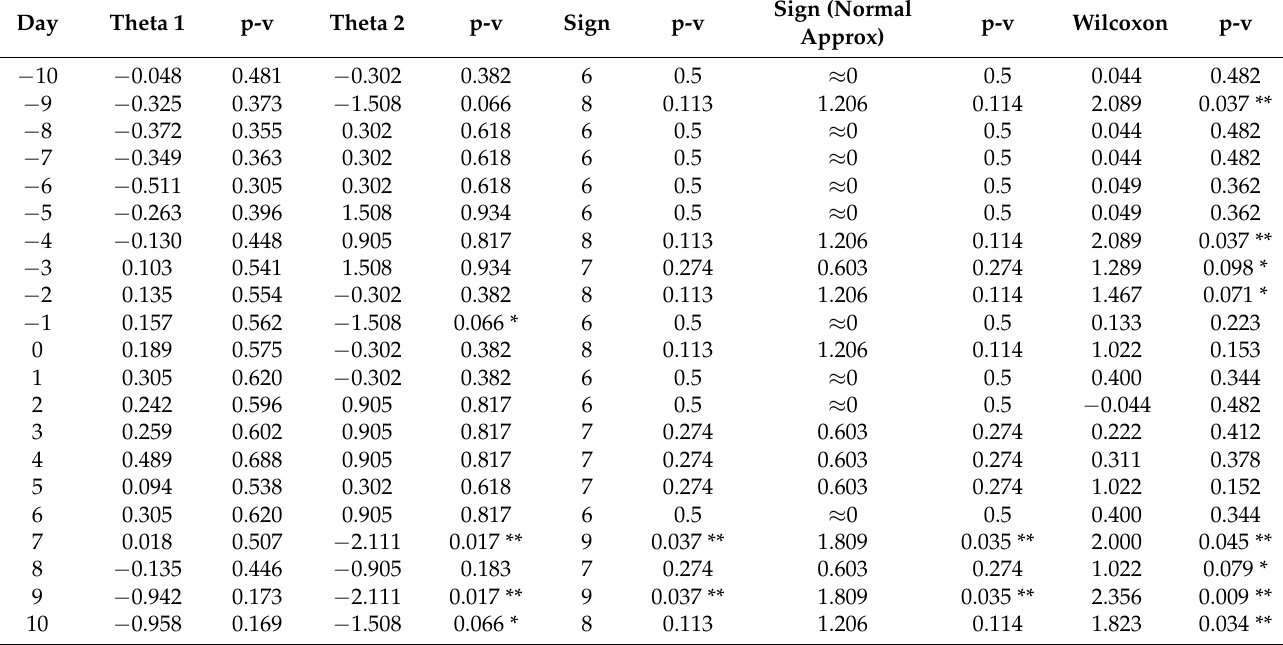
Table 4. Event study test, event